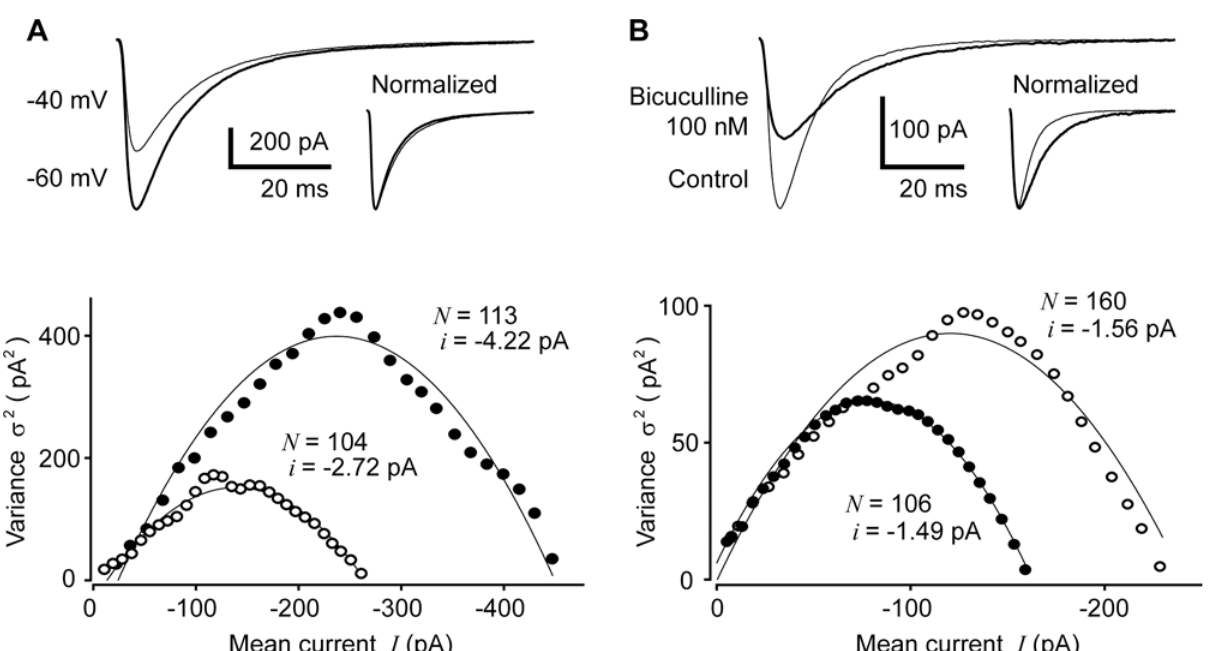
Fig 1. Validation of PS-NSFA applied to eIPSCs at GABAergic synapses between basket cells and PCs. (A) Effects of changing the driving force for GABA A receptor activation on eIPSCs. Upper panel: averaged traces of eIPSCs recorded at the holding membrane potential of – 40 mV (thin line) and -60 mV (thick line). Inset shows the averaged trace of IPSCs recorded at − 40 mV was scaled to the same amplitude of those recorded at – 60 mV (Normalized). Lower panel: mean-variance curves at the membrane potentials of – 40 (open circles) and – 60 mV (closed circles). N and i indicate the number of active GABA A receptors and the size of unitary current through GABA A receptors estimated from the mean-variance curves, respectively. (B) Effects of changing the GABA A receptor availability by bicuculline on eIPSCs. Upper panel: averaged traces of eIPSCs before (control) and after bath-application of the GABA A receptor antagonist bicuculline (100 nM). Inset shows averaged trace of IPSCs in the presence of bicuculline was scaled to the same amplitude of those recorded in control solution (Normalized). Note that the decay time was prolonged after partial blockade of GABA A receptors by bicuculline. Lower panel: mean-variance curves before (open circles) and after (closed circles) application of bicuculline. N and i indicate the number of active GABA A receptors and the size of unitary current through the GABA A receptor estimated from the mean-variance curves, respectively.